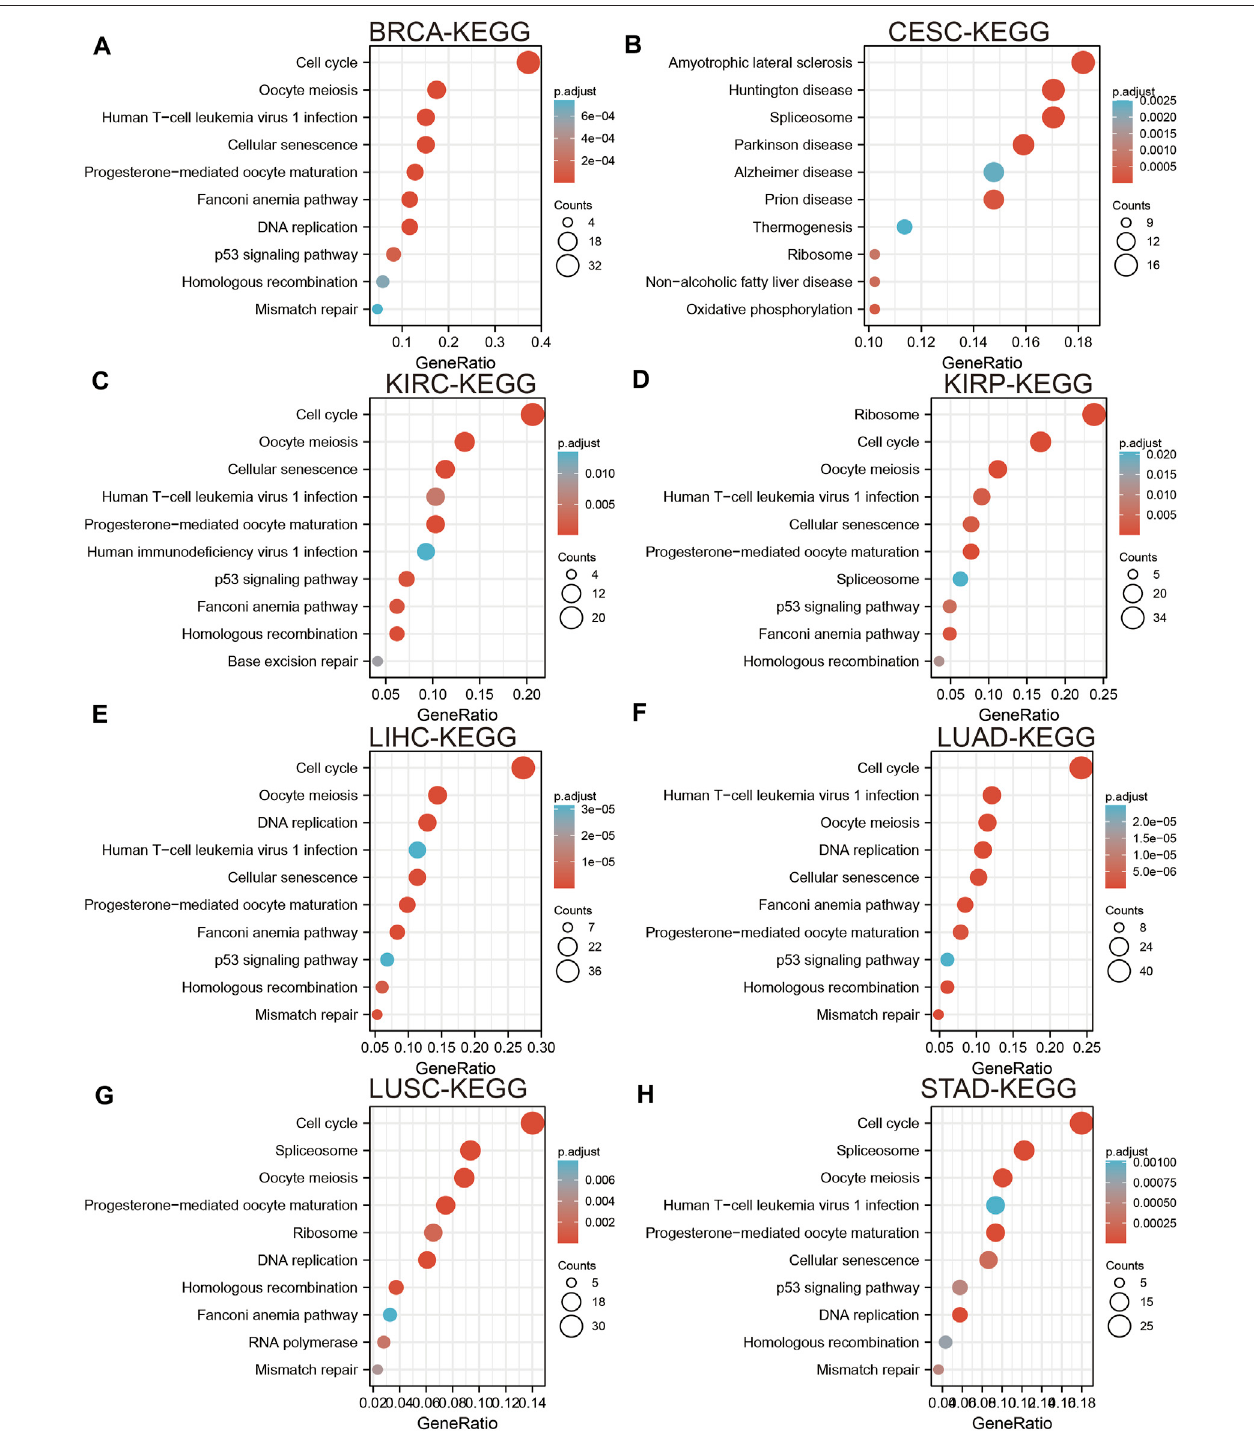
FIGURE 5 | Analysis the signaling pathway for UBE2C in human cancers. (A – D) The KEGG pathway of UBE2C in BRCA, CESC, KIRC, and KIRP examine by LinkedOmics. (E – H) The KEGG pathway of UBE2C in LIHC, LUAD, LUSC, and STAD examined by LinkedOmics.